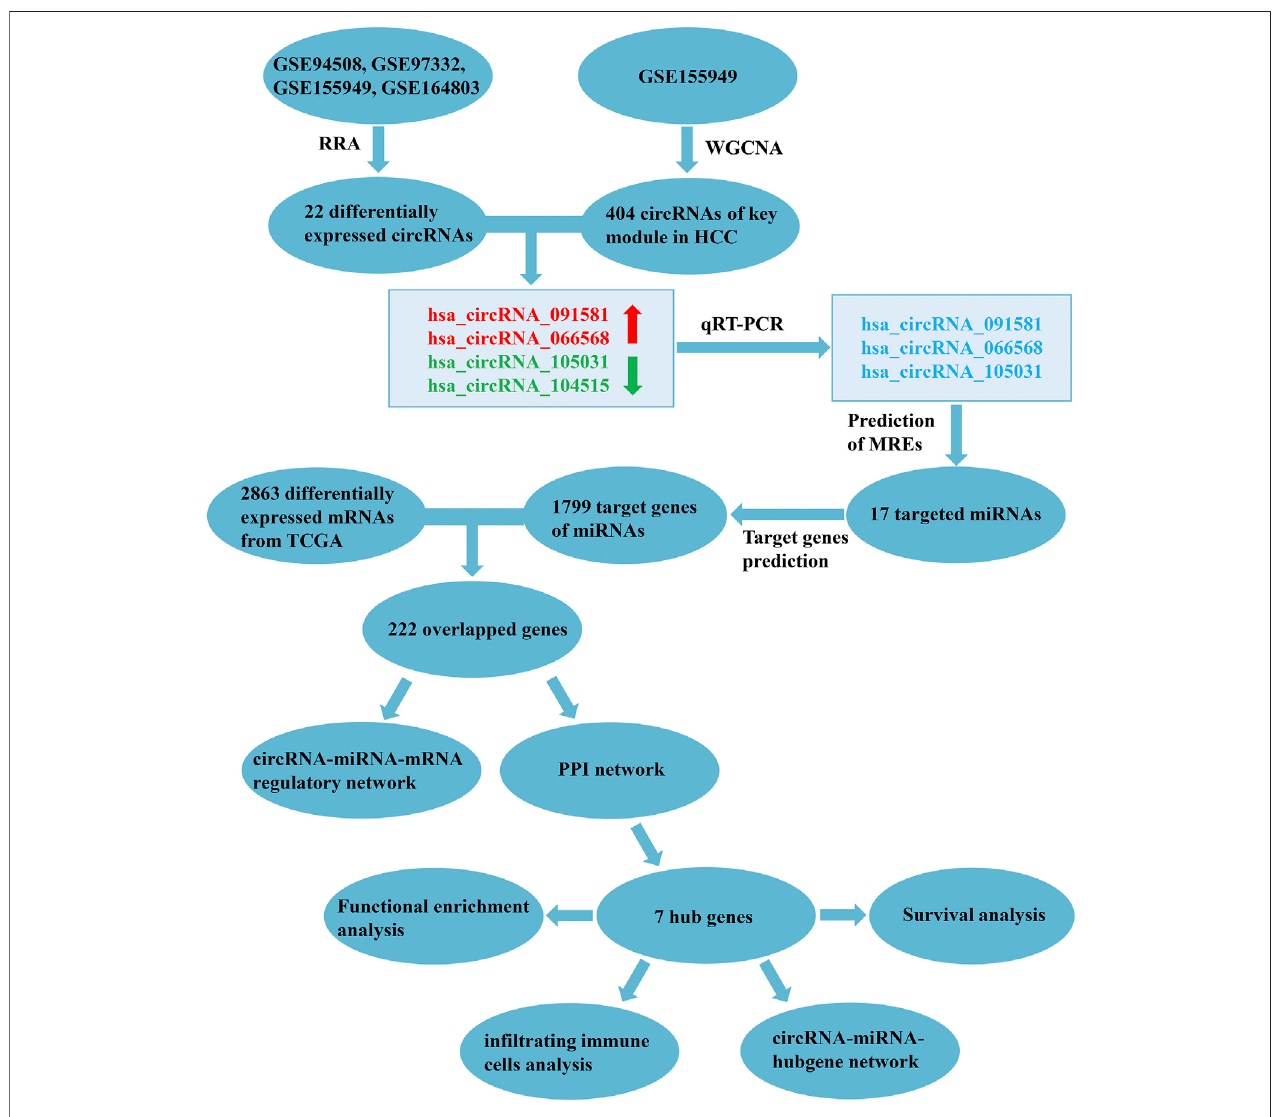
FIGURE1| Flowchartofthepresentstudy.RRA,robustrankaggregation;WGCNA,weightedgeneco-expressionnetworkanalysis;HCC,hepatocellularcarcinoma;qRT- PCR, quantitative real-time polymerase chain reaction; MREs, miRNA response elements; TCGA, the Cancer Genome Atlas; PPI, protein-protein interaction.